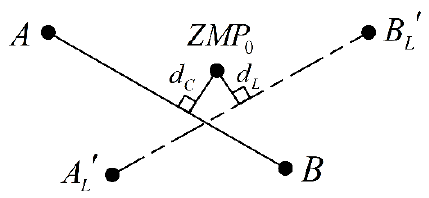
Figure 9. Angle between 𝐹 𝑒 and 𝑥 𝑠 .